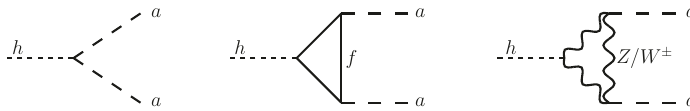
Figure 14 . Feynman diagrams contributing to the decay h Higgs couplings to W and Z